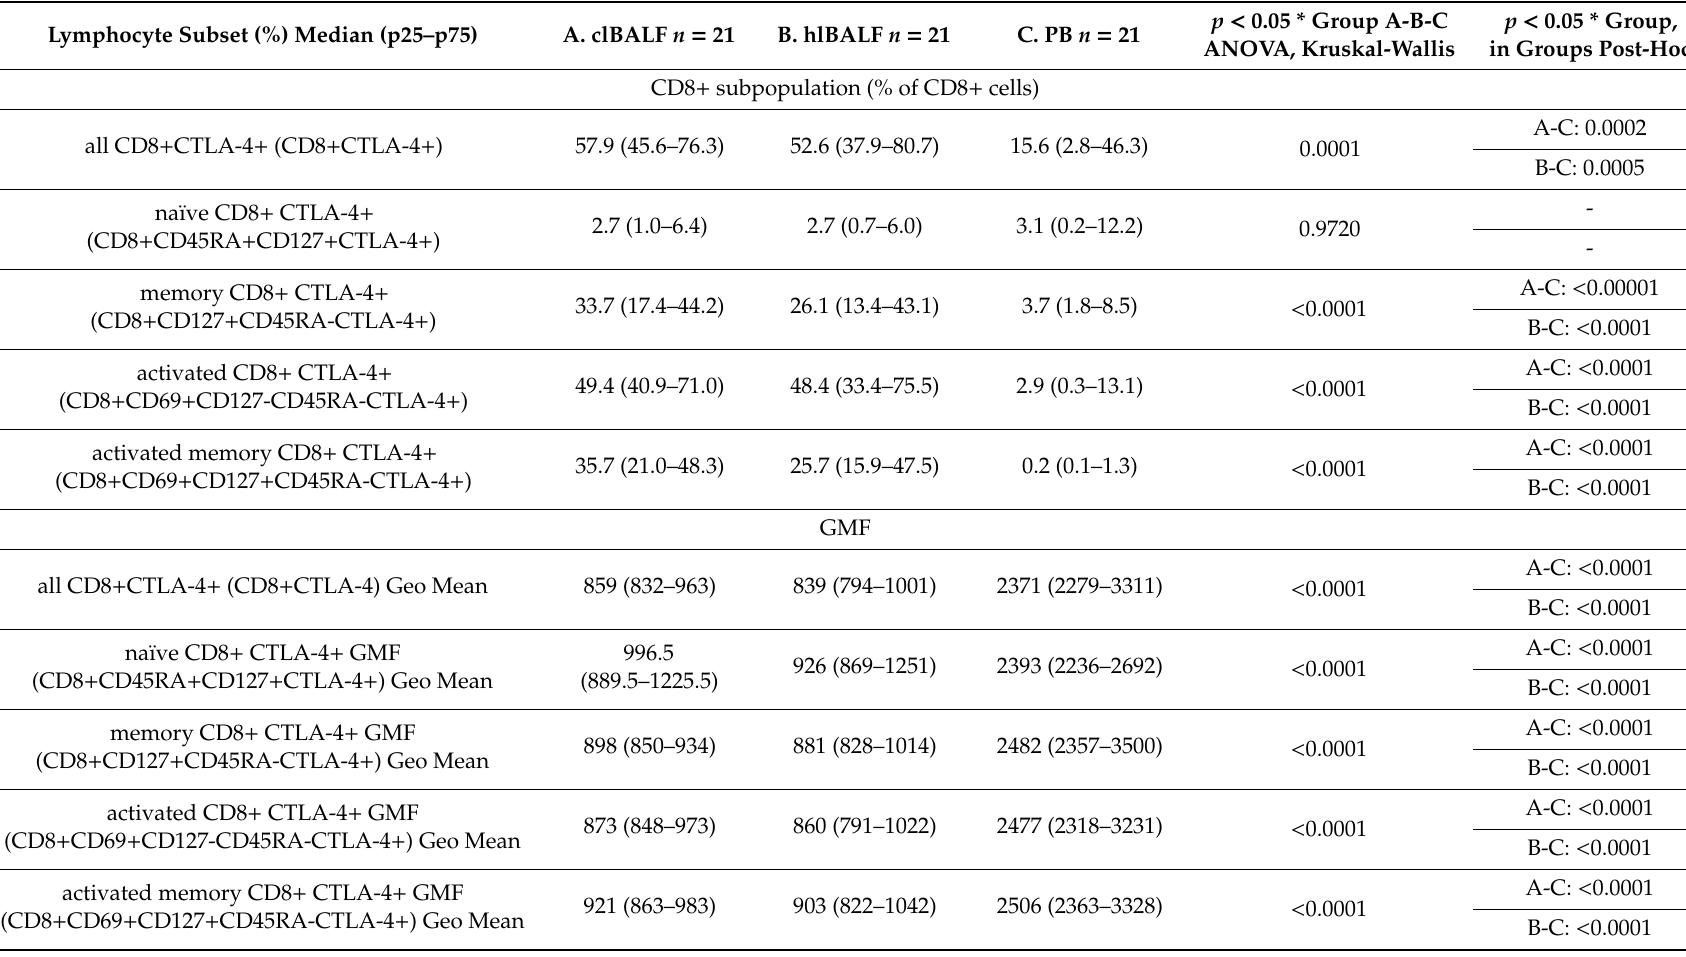
Table 4. Proportion of lymphocyte subtypes with the expression of CTLA-4 and the geometric mean fluorescence (GMF) intensity of CTLA-4 on CD8, CD4 lymphocyte subpopulations in patients with lung cancer. Comparison of the proportion of cells between three compartments: the tumor environment clBALF, ‘healthy’ lung (hlBALF) and peripheral blood (PB). Data expressed as median